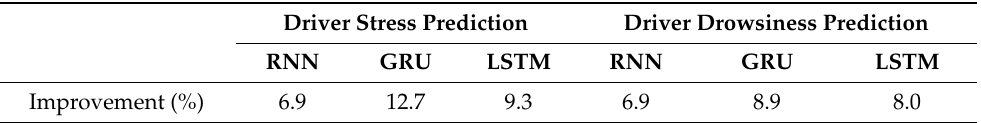
Table 5. The improvement of OA all achieved by the proposed algorithm, compared with the perfor- mance of the boosting learning of multiple RNNs, GRUs, and LSTMs algorithms. Driver Stress Prediction Driver Drowsiness